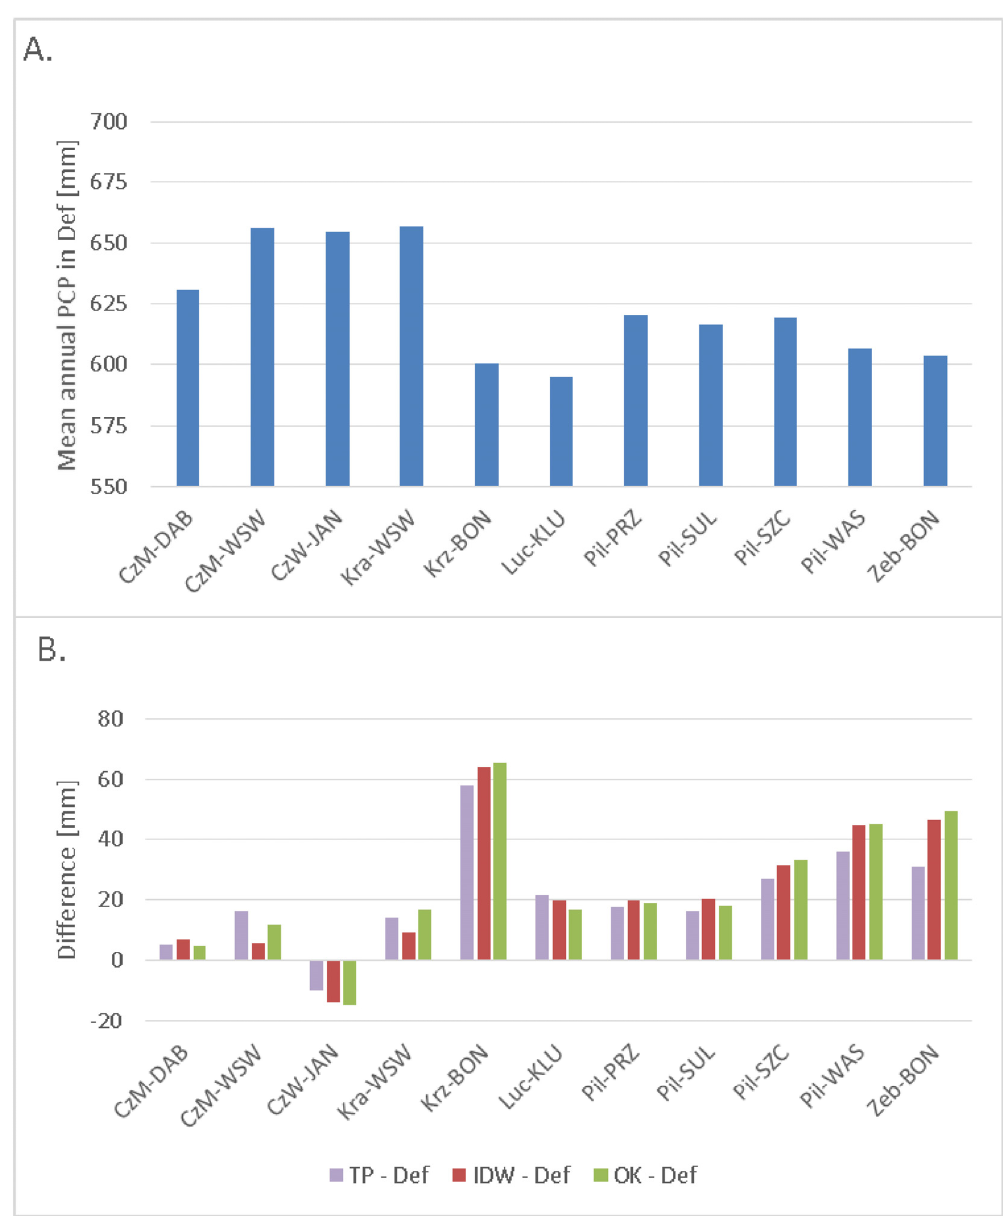
Figure 4. Mean annual precipitation for the period 1982–2011 calculated for 11 studied catchments for the Default method ( A ); The difference in mean annual precipitation between three interpolation methods (TP, IDW, OK) and Def ( B